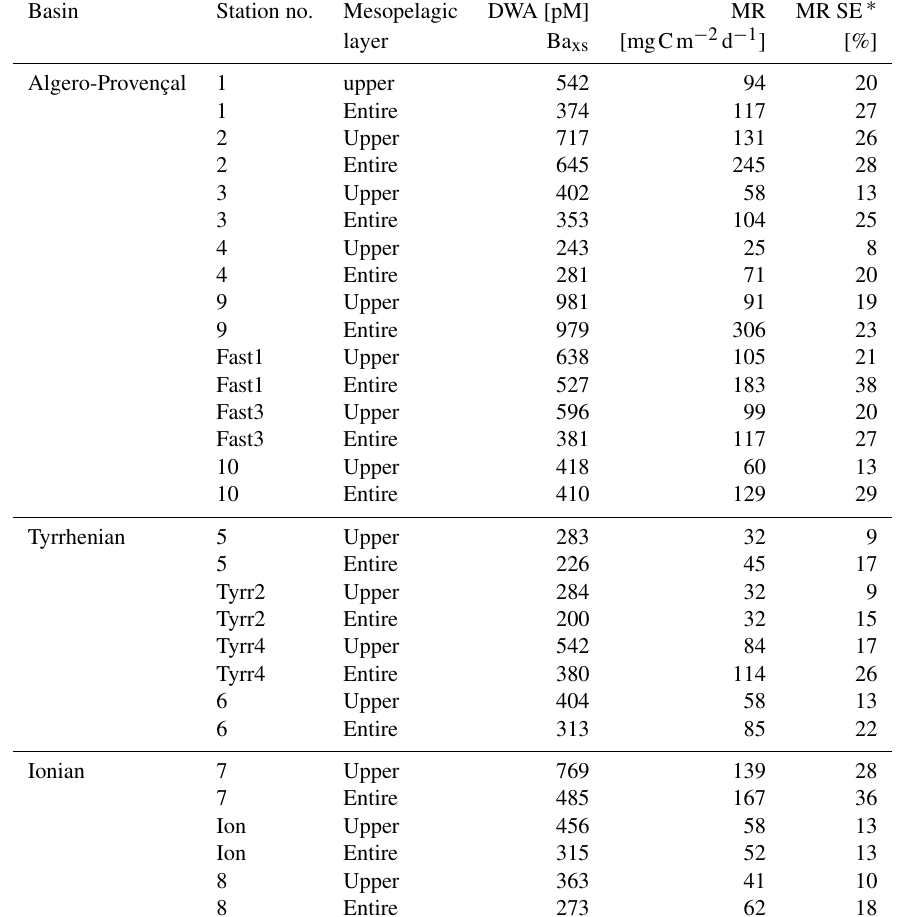
Table 1. Depth-weighted average (DWA) concentrations of Ba xs (pM) and the remineralization rate (MR; mgCm − 2 d − 1 ) for the upper (100– 500m depth) and entire (100–1000m depth) mesopelagic